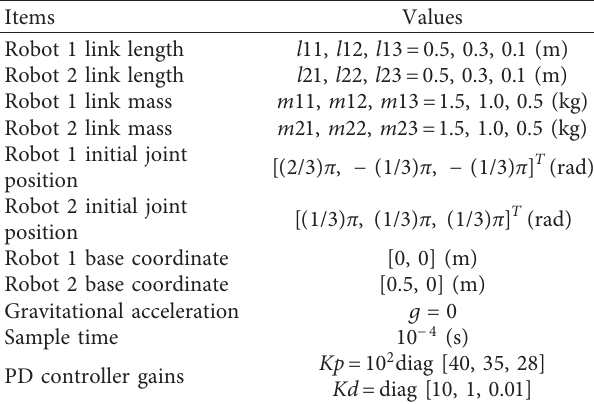
Table 1: Partial parameters of the bimanual robot system. Items